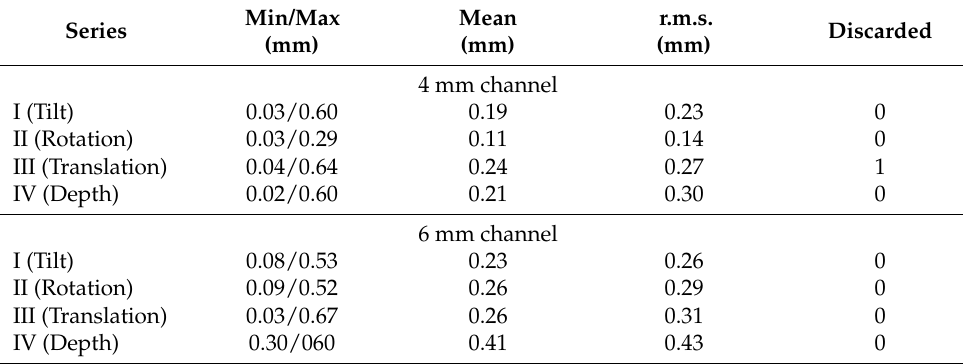
Table 4. In vitro segmentation